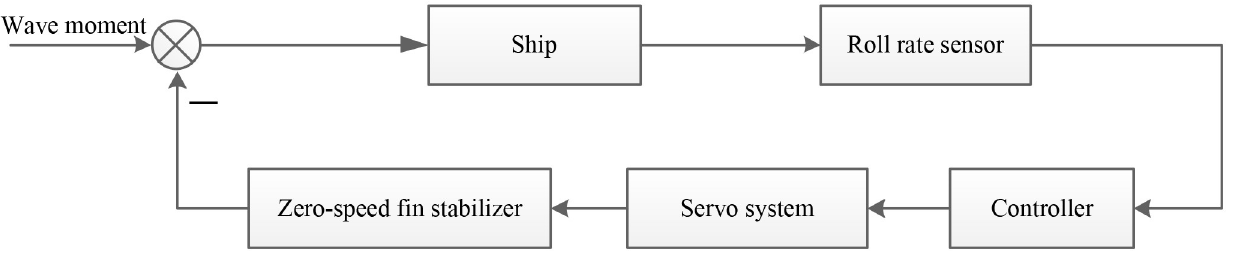
Fig 7. Flowchart of the zero-speed fin stabilizer roll reduction